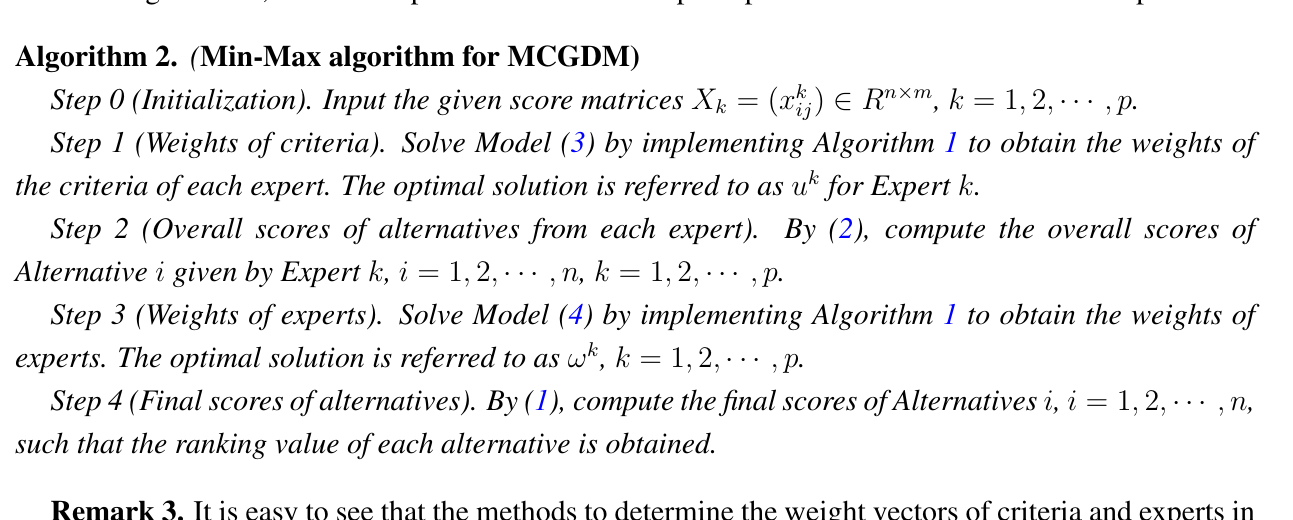
Algorithm 2. ( Min-Max algorithm for